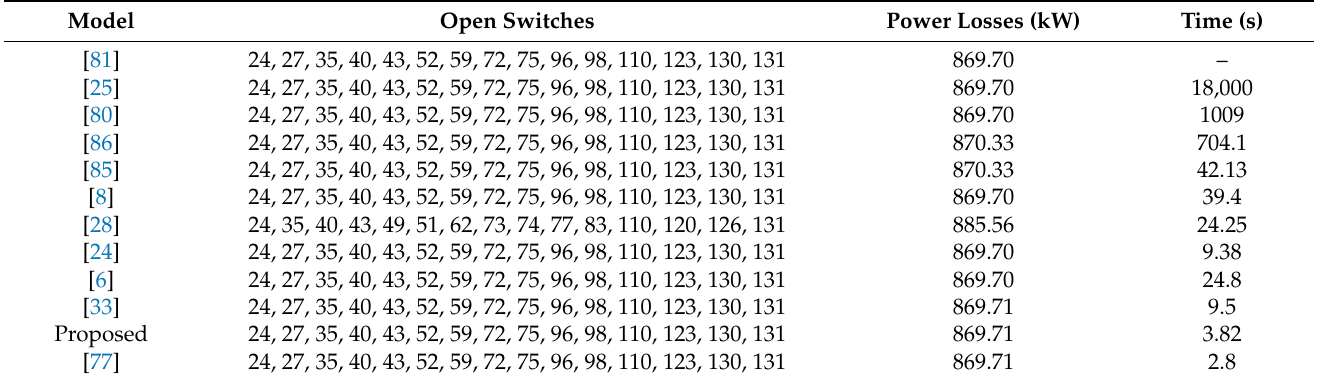
Table 14. Comparative analysis of the 119-bus test system.